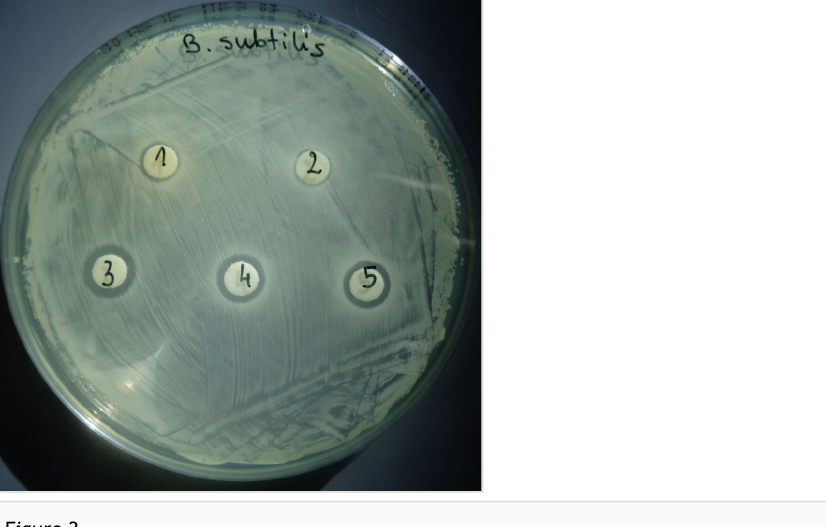
Antimicrobial susceptibility test. Zones of inhibition of the tester strain B. subtilis were observed in three out of fi ve disks containing fractions of reversed-phase